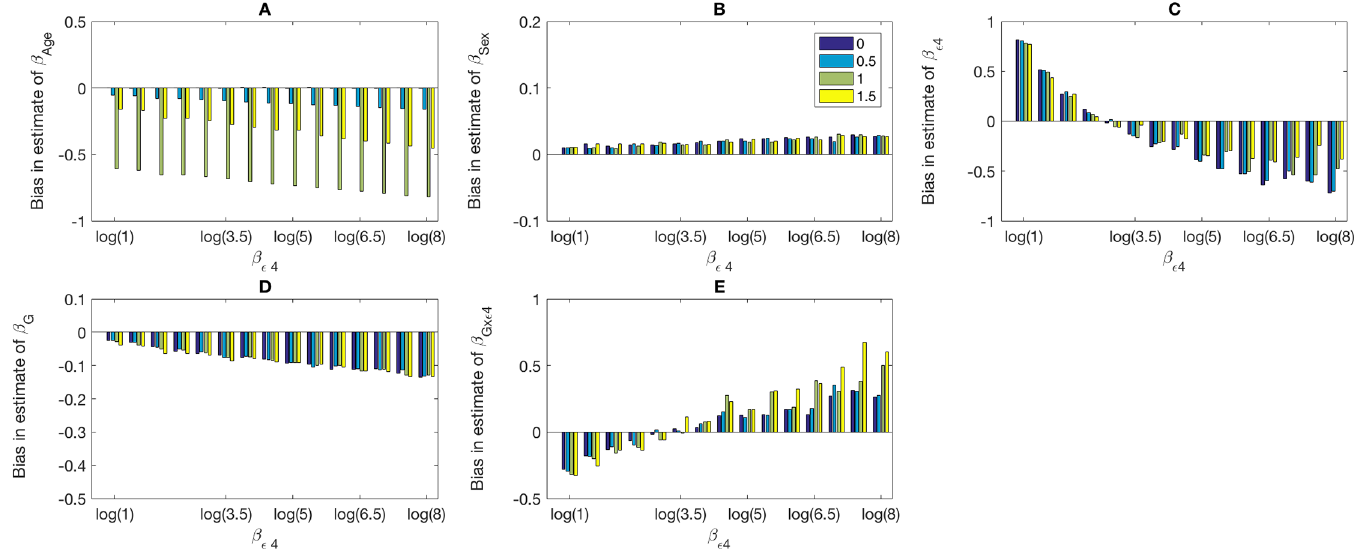
Fig 1. The bias in estimates of β outcome across values of β ε 4 . Simulated are datasets with 3,000 cases and 3,000 controls. Values of β indicated by color. The parameters are set as follows: β 0 = − 1, β pr(D = 1 (cid:3) | D CL = 1, ε 4-) = 0.36 and pr(D = 1 (cid:3) | D CL = 1, ε 4+) = 0.06. Variables G , Z 1 and Z 2 are Bernoulli with frequencies 0.10, 0.50 and 0.52, respectively.